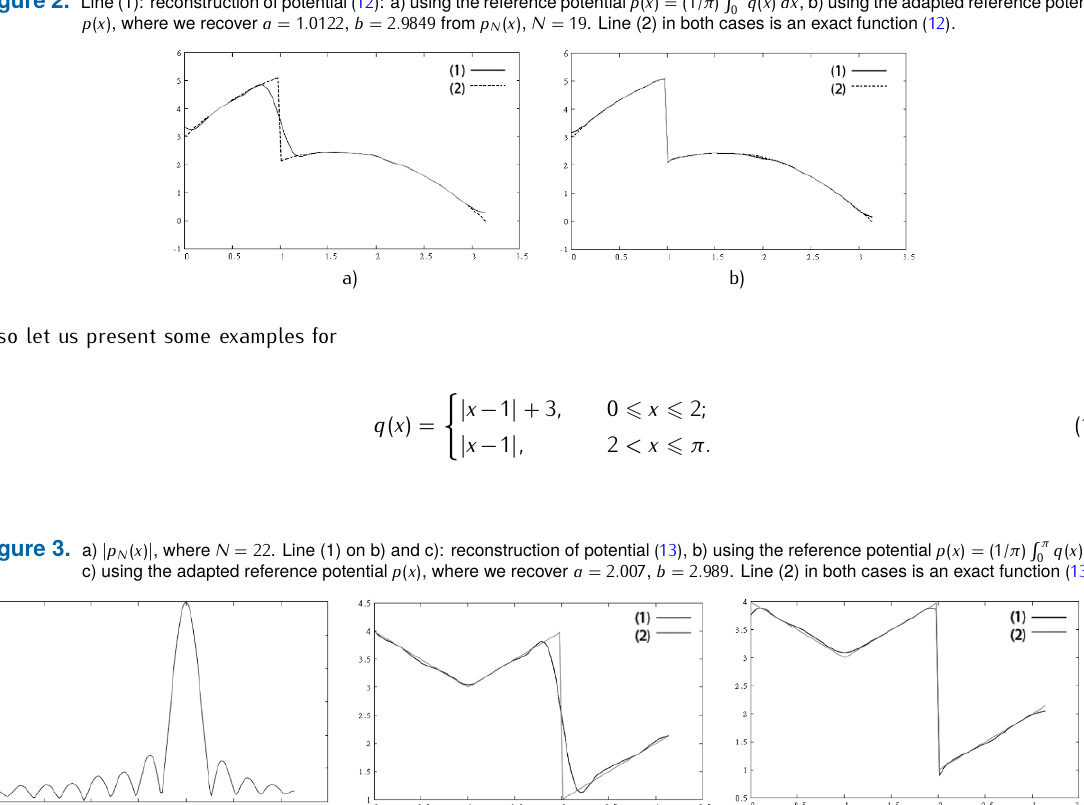
(12) : a) using the reference potential p ( x ) = (1 /π